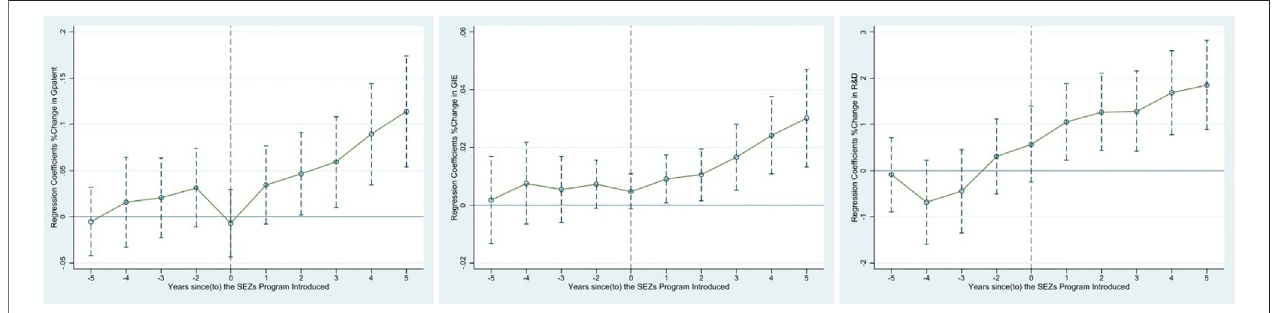
FIGURE 2 | Results of the parallel trend